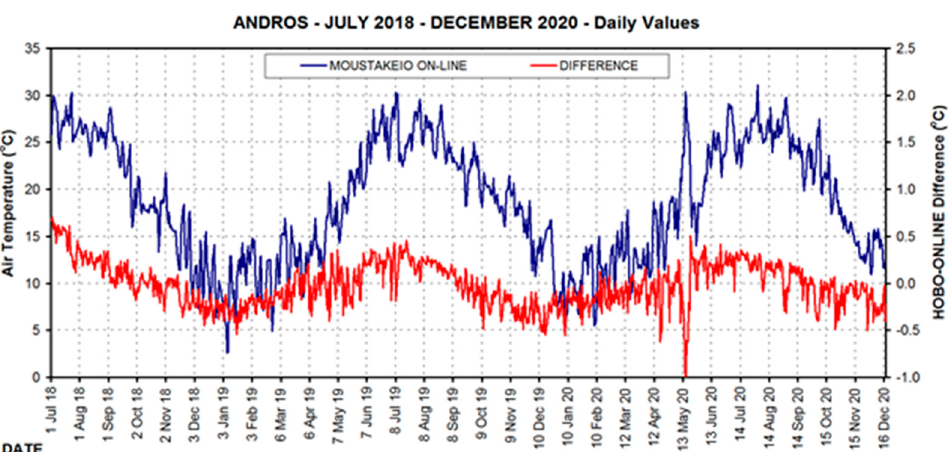
Figure 2. Plot of daily mean values of air tempertatures at Moustakeio central online station (blue line) with the differences of the smal HOBO sensor from the central on-line station (red line).